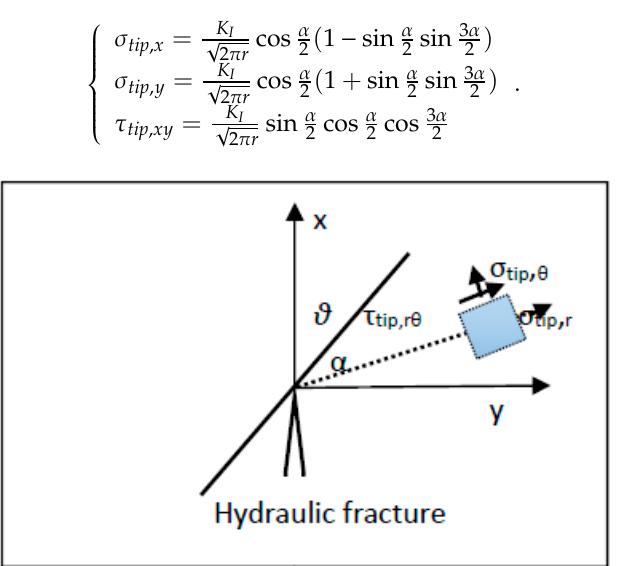
Figure 2. The illustration of stress distribution at the tip of the hydraulic fracture. The thin, black line represent the natural fracture. The dotted line denotes one random scenario of the natural fracture which is used for the analysis of stress distribution.